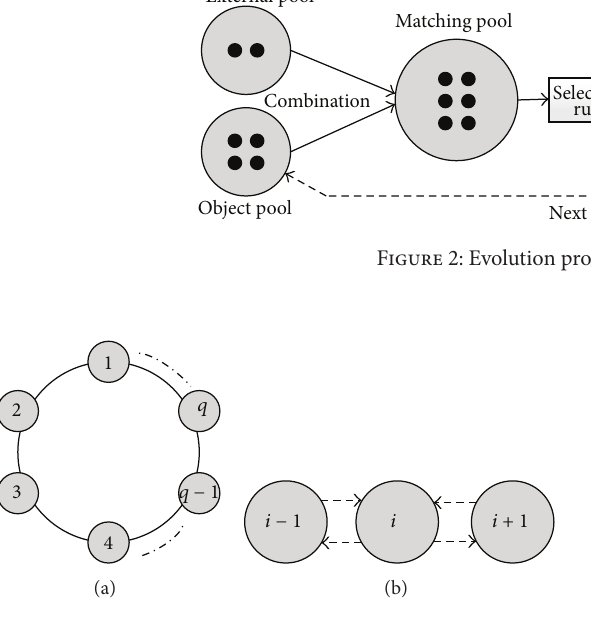
Figure 3: A loop topology structure of cells and the communication relation between adjacent cells.